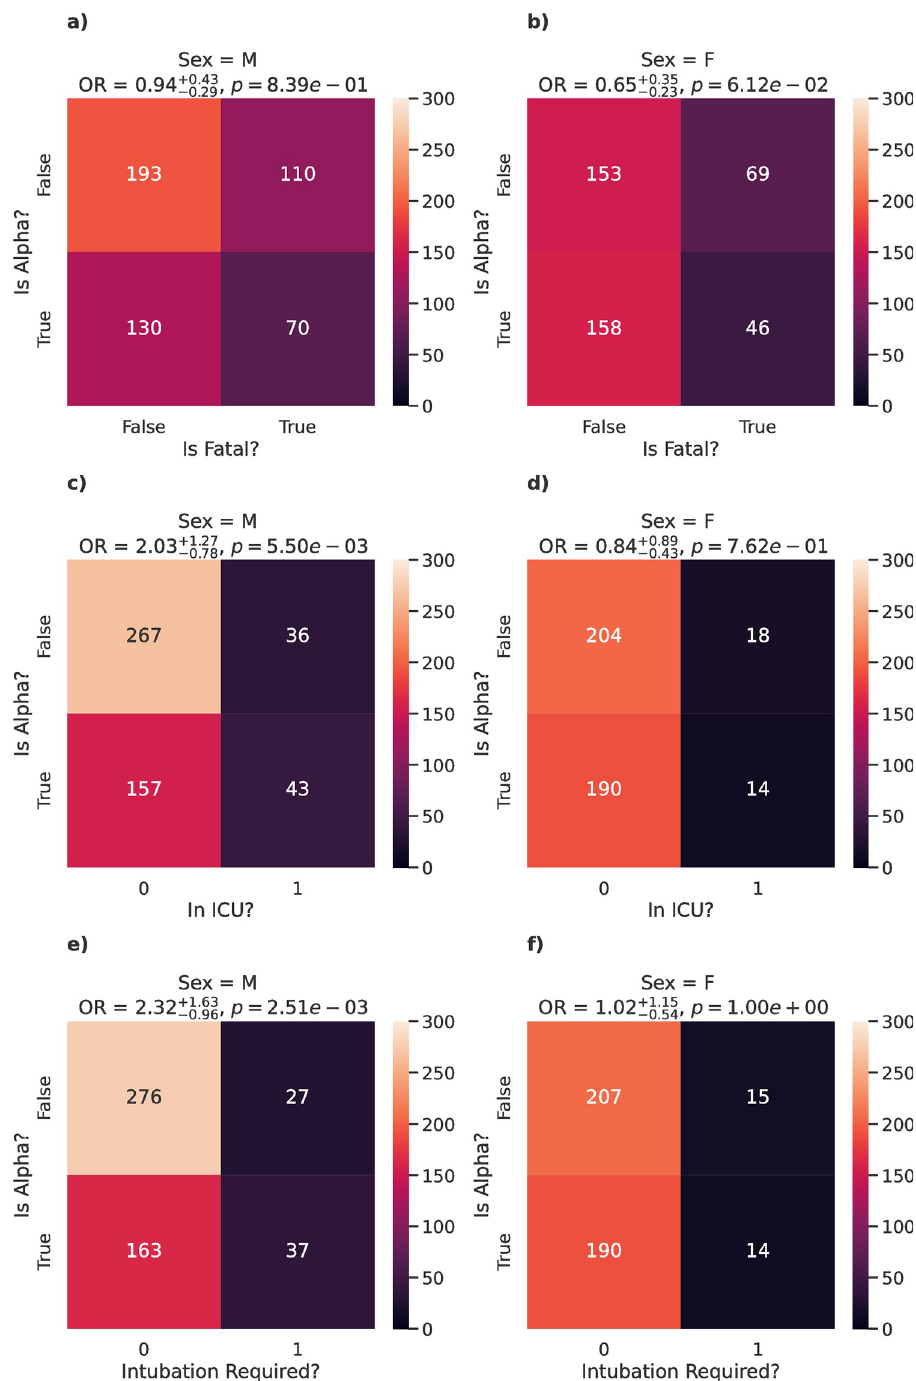
Fig 4. Effect of the Alpha variant on disease severity for male and female patients. Heatmaps exploring the changes in relative risk of death (a-b), ICU admission (c-d) and intubation (e-f) for male and female patients when comparing Alpha cases to non-Alpha cases. The odds ratio and p-values p between the classes are shown above each panel.